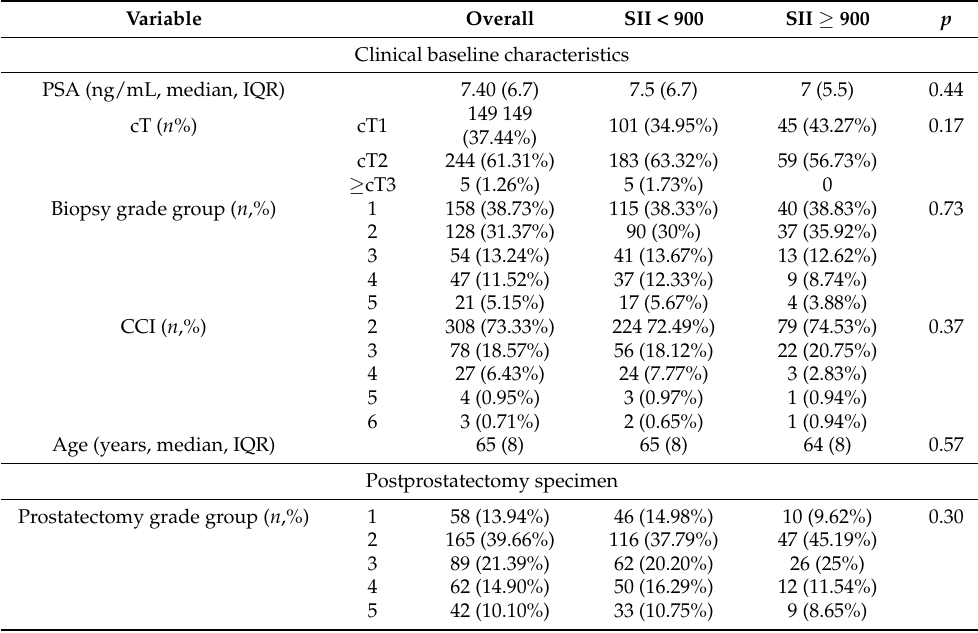
Table 1. Baseline pre- and postprostatectomy characteristics of patients stratified by SII (high vs. low).